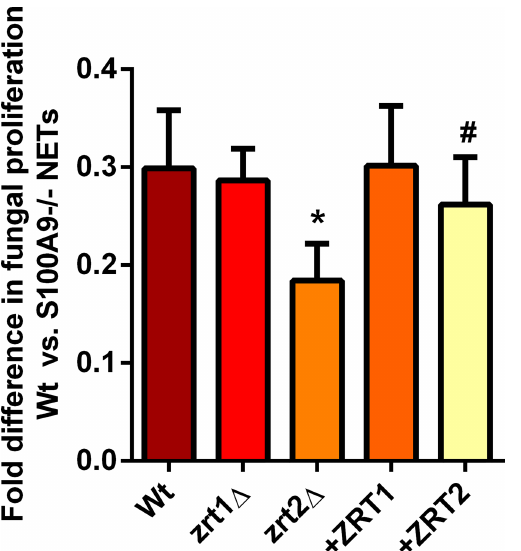
Fig 6. Zrt2 protects against calprotectin-dependent inhibition of fungal growth during C . albicans -neutrophil extracellular trap interaction. Indicated strains were incubated with wild type or S100A9-/- -derived NETs or in medium only. Following ~21 hours incubation, metabolic activity was determined by XTT assay. Activity in the presence of both NET groups was determined compared to control conditions in the absence of NETs. Experiment was performed three time. (cid:3) indicates P < 0.05 and # not significantly different to wild type, Students t-test Data presented are fold reduction in activity due to the presence of calprotectin.